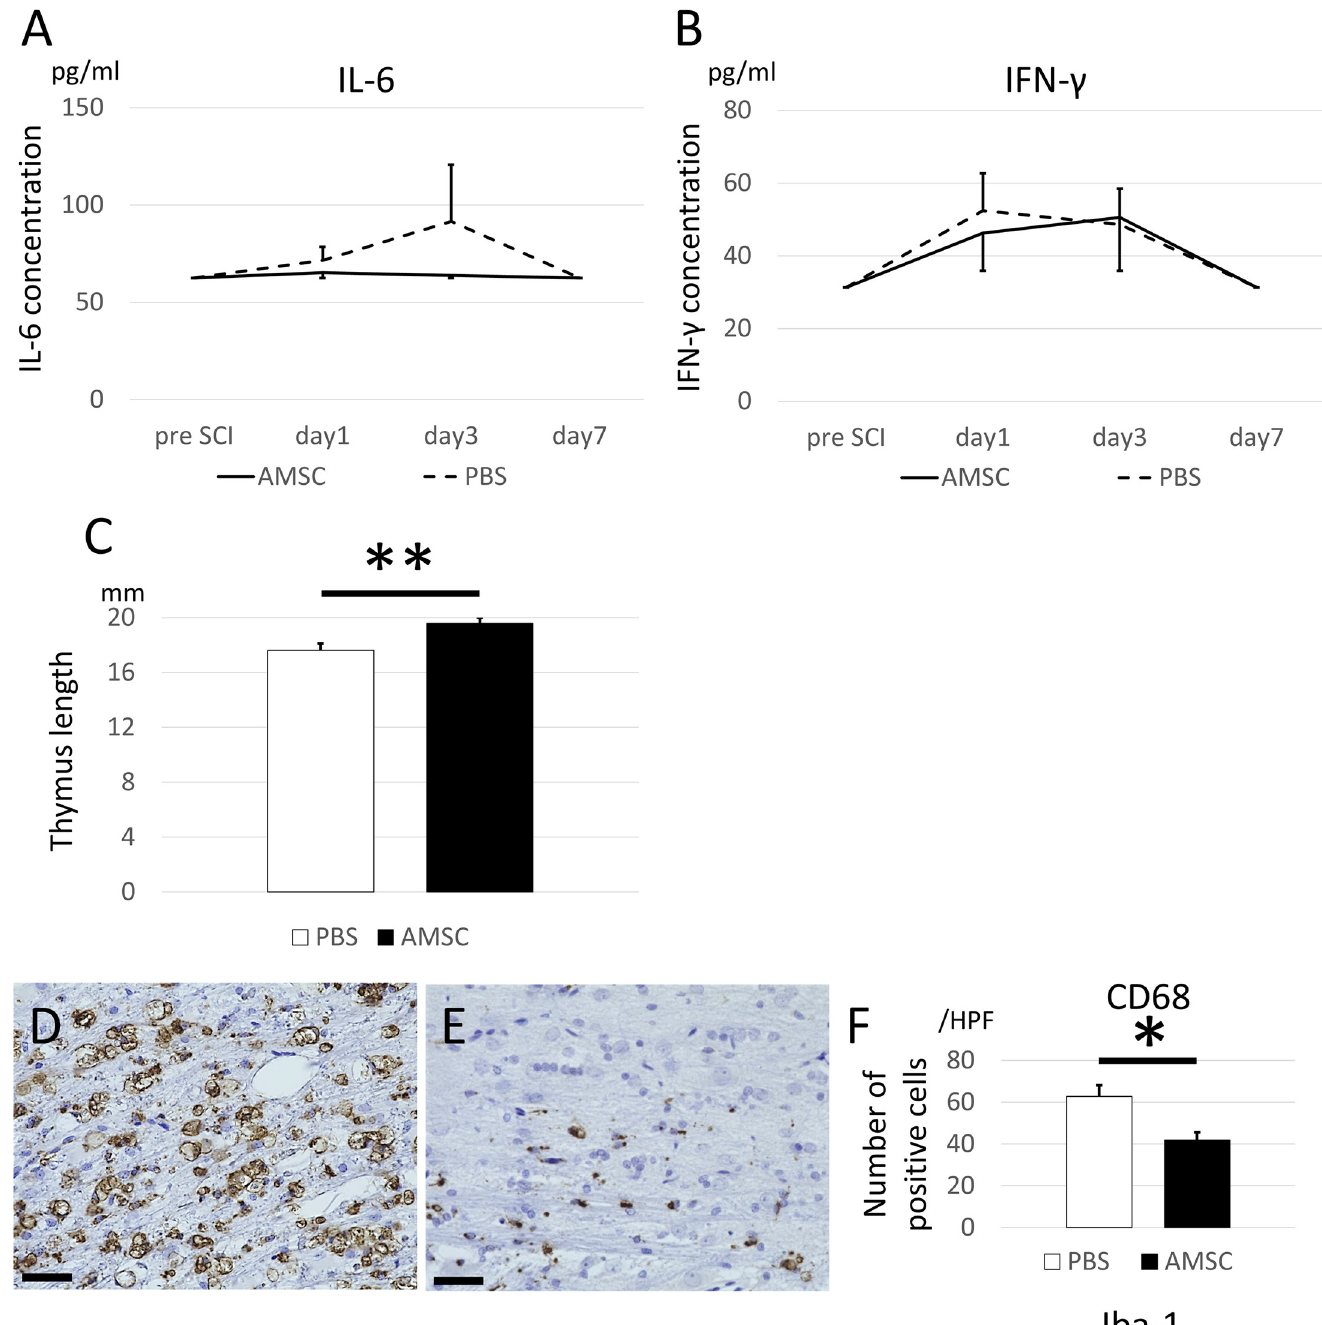
Fig 6. Systemic inflammation in the acute phase was not altered by AMSC transplantation but was reduced in the chronic phase. (A and B) ELISA using blood samples showed that IL-6 (A) and IFN- γ (B) did not increase until 7 d after SCI in both groups. (C) The systemic inflammation in the chronic phase was evaluated by measuring the organ size. The thymus height in the AMSC group was significantly higher than that in the PBS group. (D–F) Inflammation in the spinal cord was assessed via IHC staining using the anti-CD68 antibody. As for CD68, which represents blood-entered macrophage, the number of CD68-positive cells in the PBS group (D) was significantly larger than that in the PBS group (E, F; P = 0.0142) (magnification, × 400; scale bar: 20 μ m).